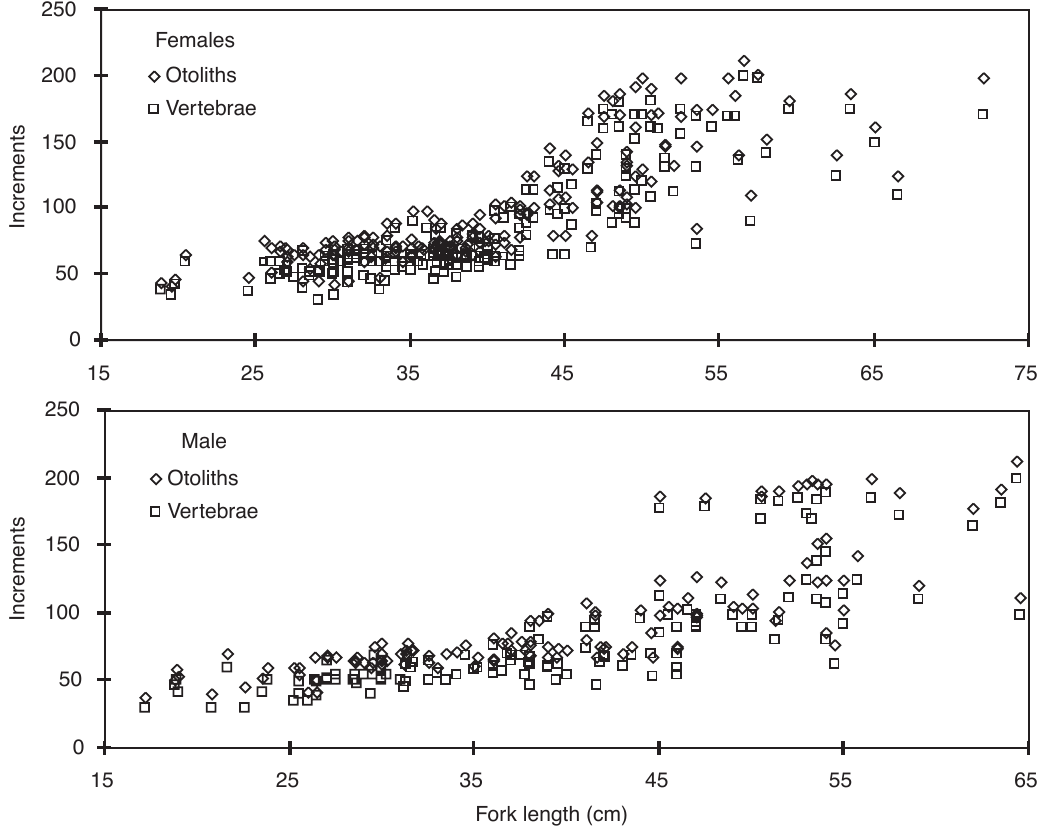
F IG . 4. – Plot of the number of rings in otoliths and vertebrae versus fork length from Sicilian dolphinfish.